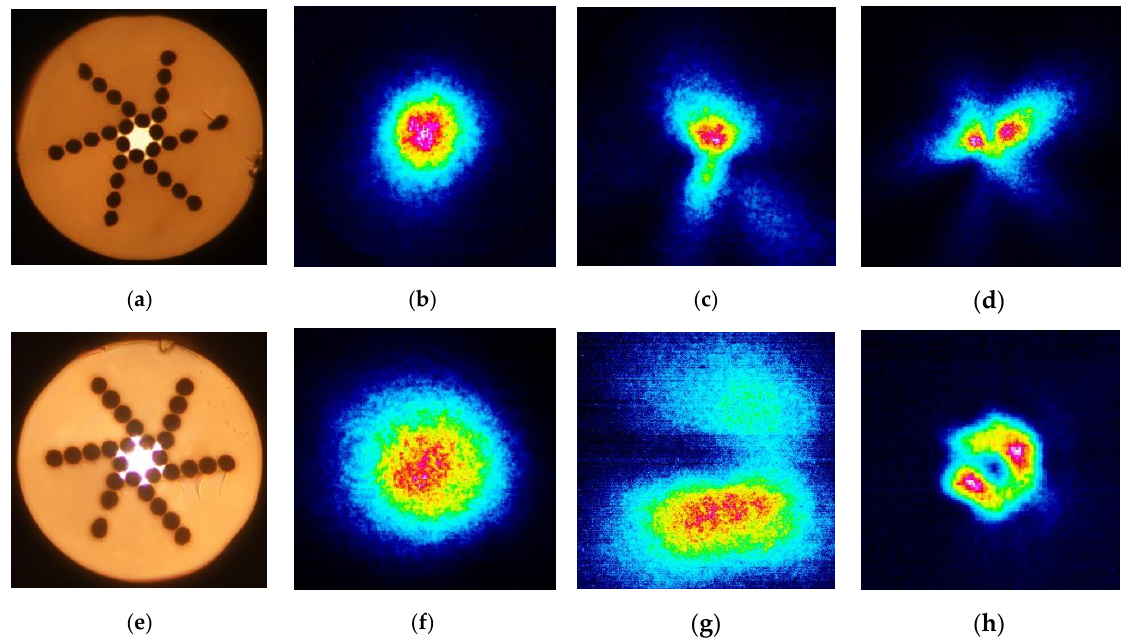
Figure 5. Near-field measurements of laser beam profile (wavelength λ = 1 550 nm) under various receiving conditions after propagation of the manufactured sample of ESSR-MOF with induced chirality of 66 revolutions per meter and length 20 m: ( a – d ) the smallest-sized air holes (air hole diameter to the pitch ratio is 0.90); ( e – h ) the maximal size of air holes (air hole diameter to the pitch ratio is 0.95); ( a , d ) — ESSR-MOF end face is placed in the focus of the camera lens; ( b ) — ESSR-MOF end face is also placed in the focus of the camera lens, receiving is performed via phase plate; ( c ) — ESSR-MOF end face is placed outside the focus of the camera lens; ( c , e ) ESSR-MOF end face is placed outside the focus of the camera lens; ( f ) — ESSR-MOF end face is placed outside the focus of the camera lens, image is focused via outer lens.